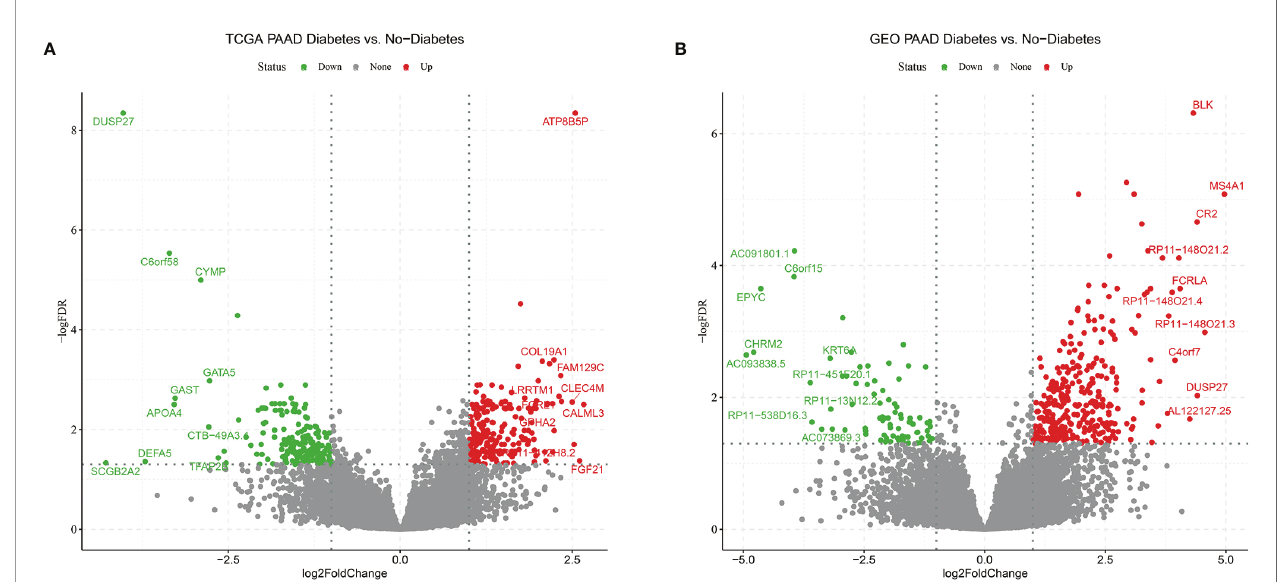
FIGURE 1 | Volcano plot (A) Differentially expressed genes in the TCGA PAAD dataset for diabetic vs. non-diabetic. (B) Differentially expressed genes between diabetic and non-diabetic in the GSE79668 dataset. FDR<0.05,abs(log2FoldChange)>1 used as cutoff value for the volcano